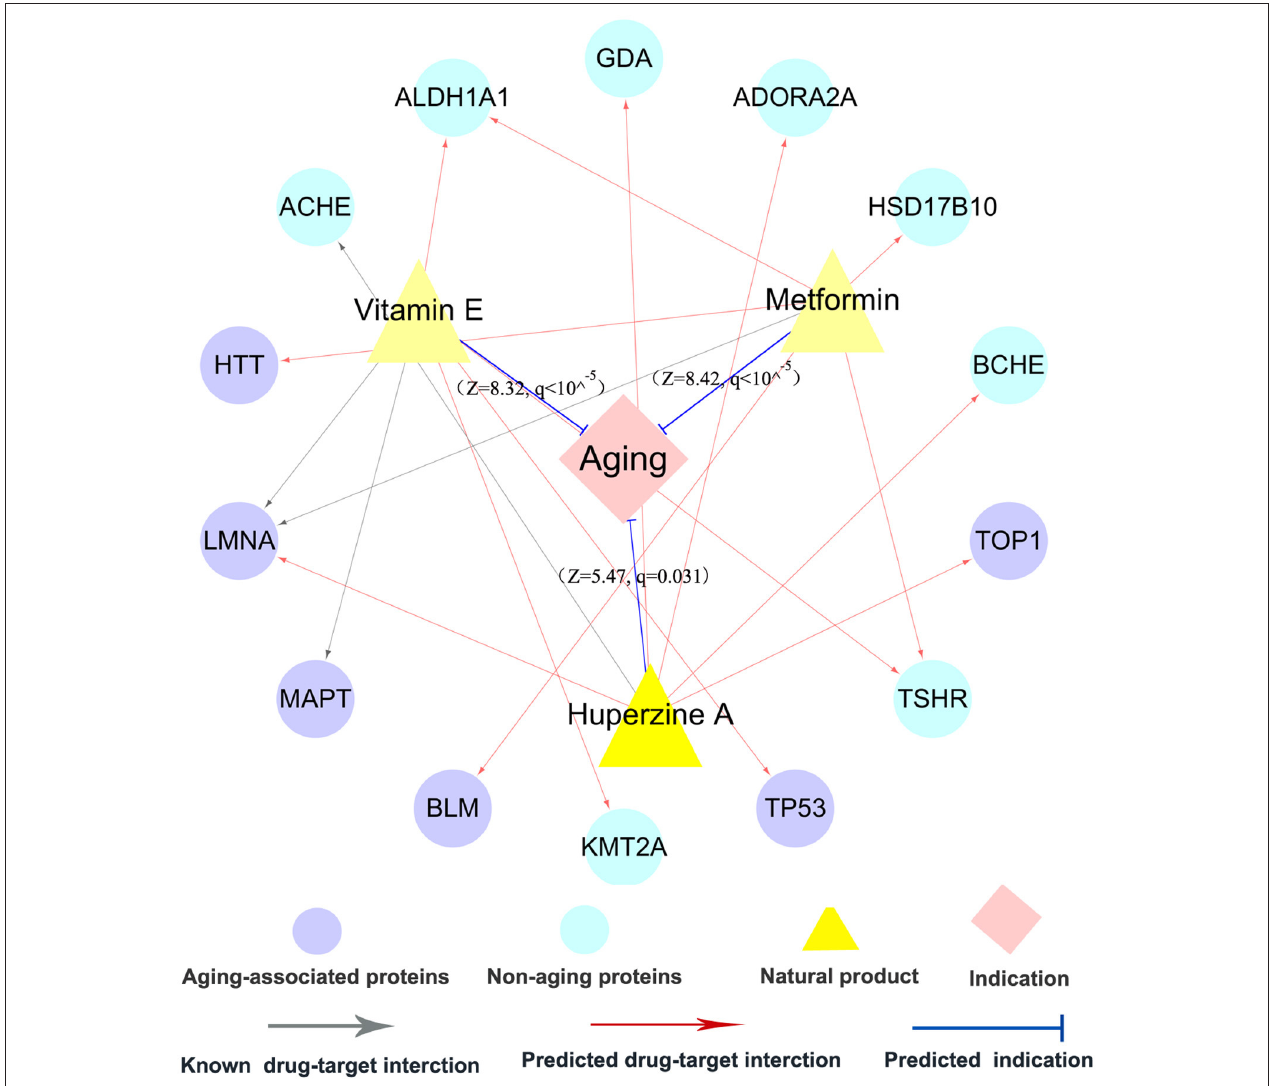
FIGURE 6 | A discovered anti-aging drug-target network for 3 typical natural products. This network displays the predicted anti-aging indications as well as the known and predicted drug targets for three typical natural products: metformin, vitamin E, and huperzine A. The thickness of blue line between natural products and anti-aging indication is proportional to the predicted Z-score (Equation 2, see section Materials and